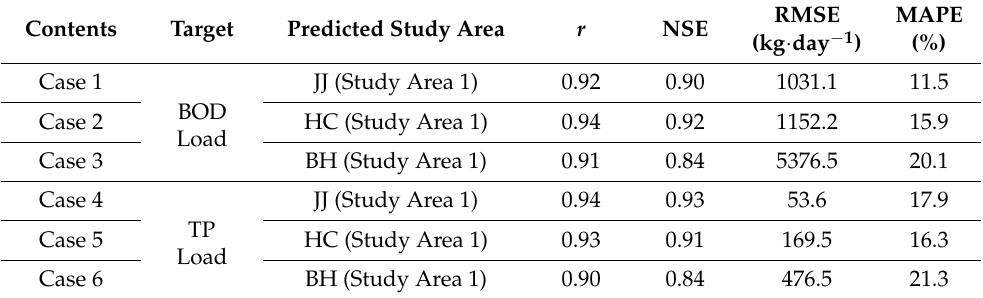
Table 5. Results of the model